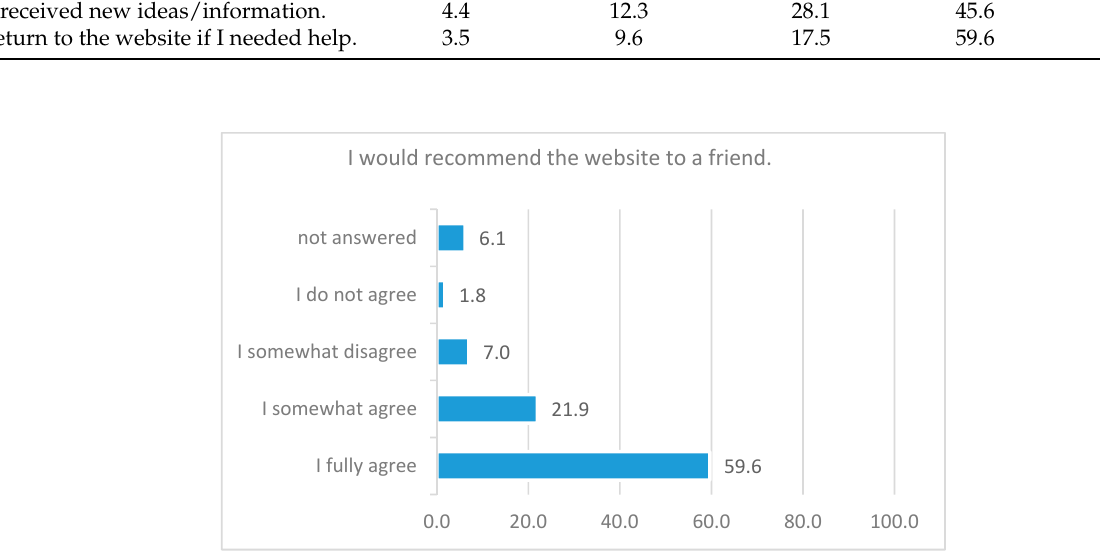
Figure 5. Response rate to the statement “I would recommend the website to a friend”, in percent, N = 114.